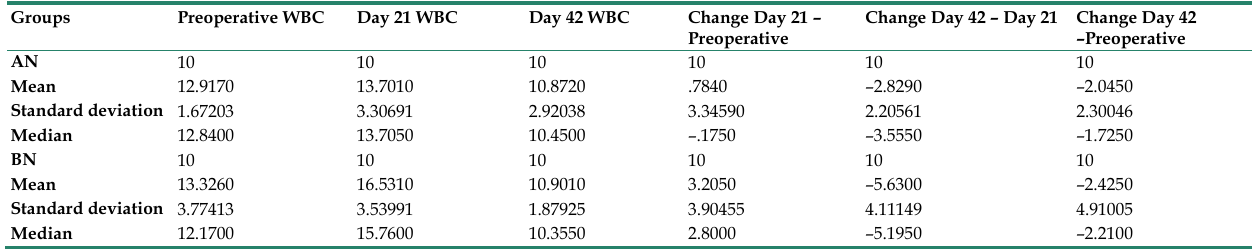
Table 3 : WBC counts of rats on days 21 and 42. Groups